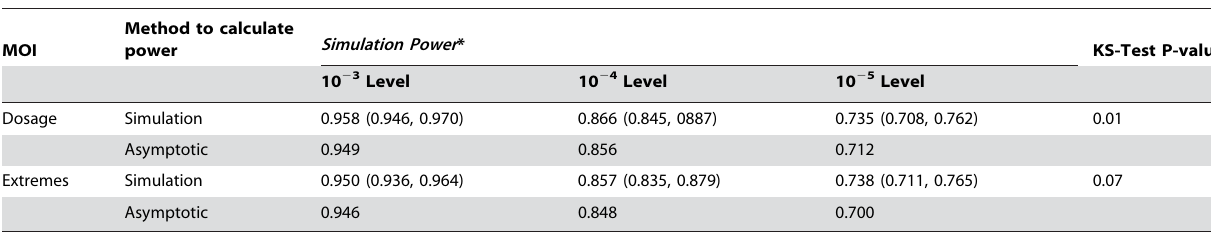
Table 3. Simulation results for LRTS under alternative distributions.